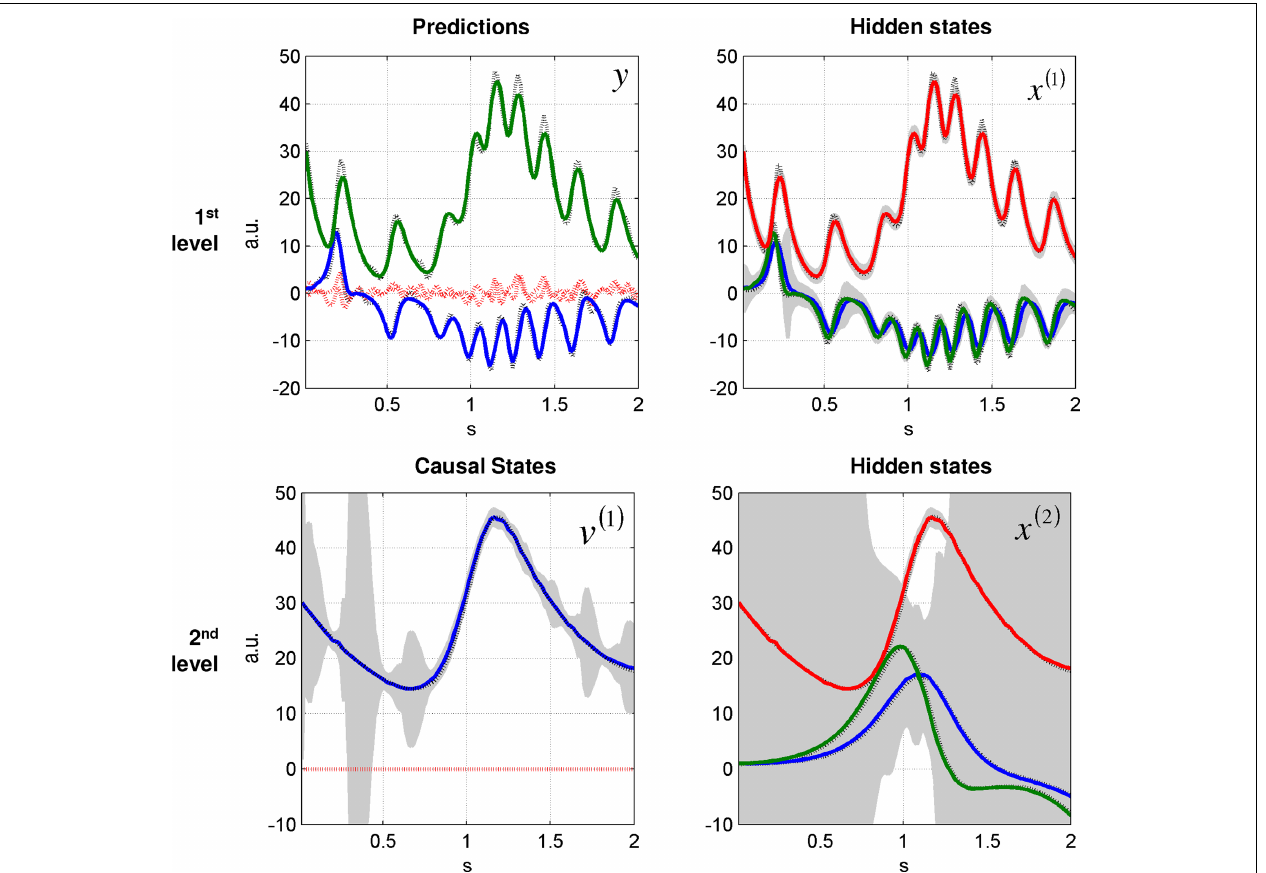
FIGURE 3 | Dynamic online inversion of the data presented in Figure 2. Observed data (see Figure 2 ) are now shown as black, dotted lines, and the model predictions as solid, coloured lines. The 90% confi dence interval